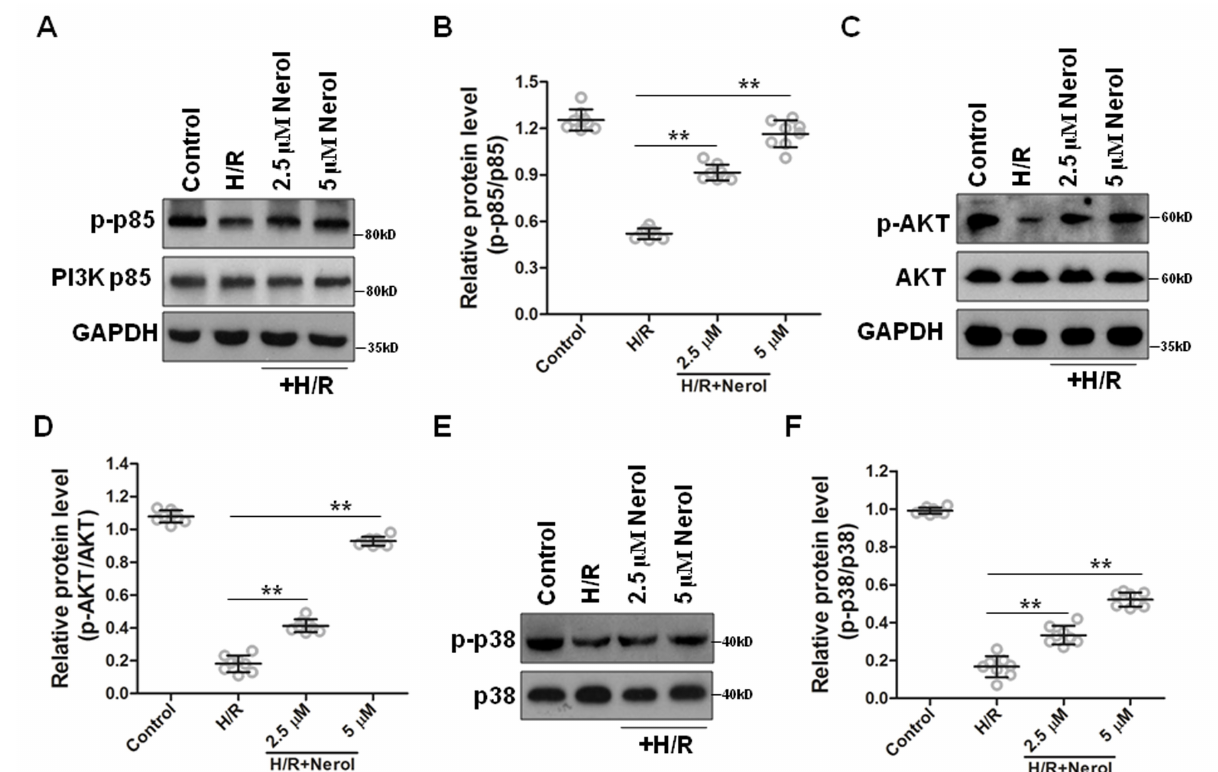
Figure 4. Nerol upregulated PI3K/AKT signaling and MAPK signaling in cardiomyocytes. (A & B) H9c2 cardiomyocytes were treated with 2.5 μM or 5 μM Nerol, followed by H/R treatment for 12/12 h. Then, cells were lysed for western blot against p-p85 and p85 (A). Optical density analysis for p-p85 was indicated (B). (C & D) H9c2 cardiomyocytes were treated with 2.5 μM or 5 μM Nerol, followed by H/R treatment for 12/12 h. Then, cells were lysed for western blot against p-AKT and AKT (C). Optical density analysis for p-AKT was indicated (D). (E & F) H9c2 cardiomyocytes were treated with 2.5 μM or 5 μM Nerol, followed by H/R treatment for 12/12 h. Then, cells were lysed for western blot against p-p38 and p38 (E). Optical density analysis for p-p38 was indicated (F). n=8. **p<0.01